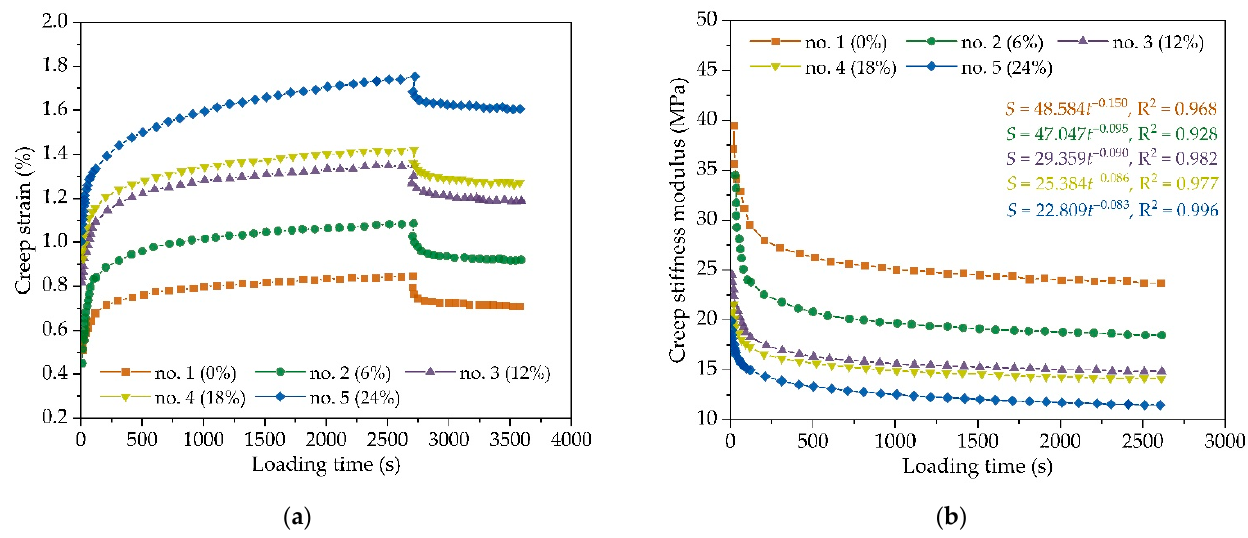
Figure 3. The uniaxial compressive creep test results of AC-16 under different chloride salt concentrations: ( a ) creep strain; and ( b ) creep stiffness modulus.